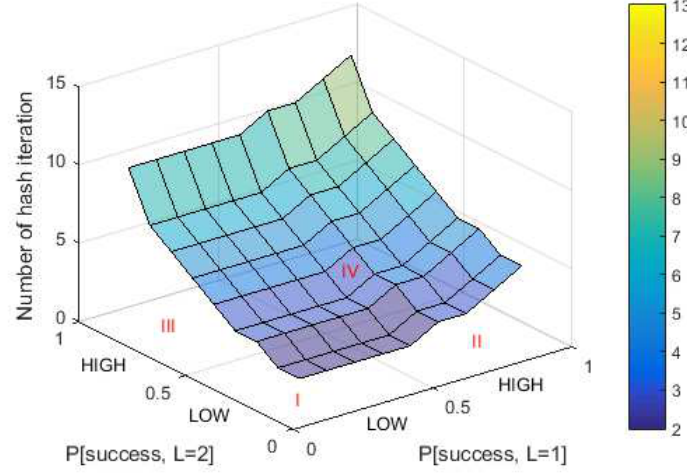
Figure 6. Number of hash iterations in DCP for L max =